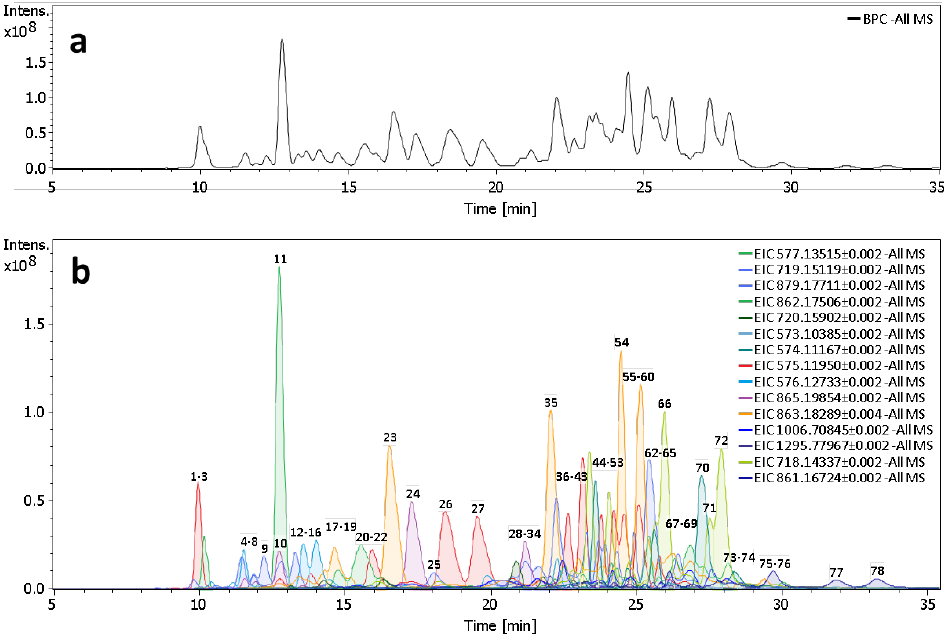
Figure 5. ( a ) Base peak chromatogram and ( b ) extracted ion chromatograms of procyanidin oligomers found in Vaccinium macrocarpon purified press residue extract by LC-HRMS. The numbers above peaks represent the identified procyanidins in Table 4.